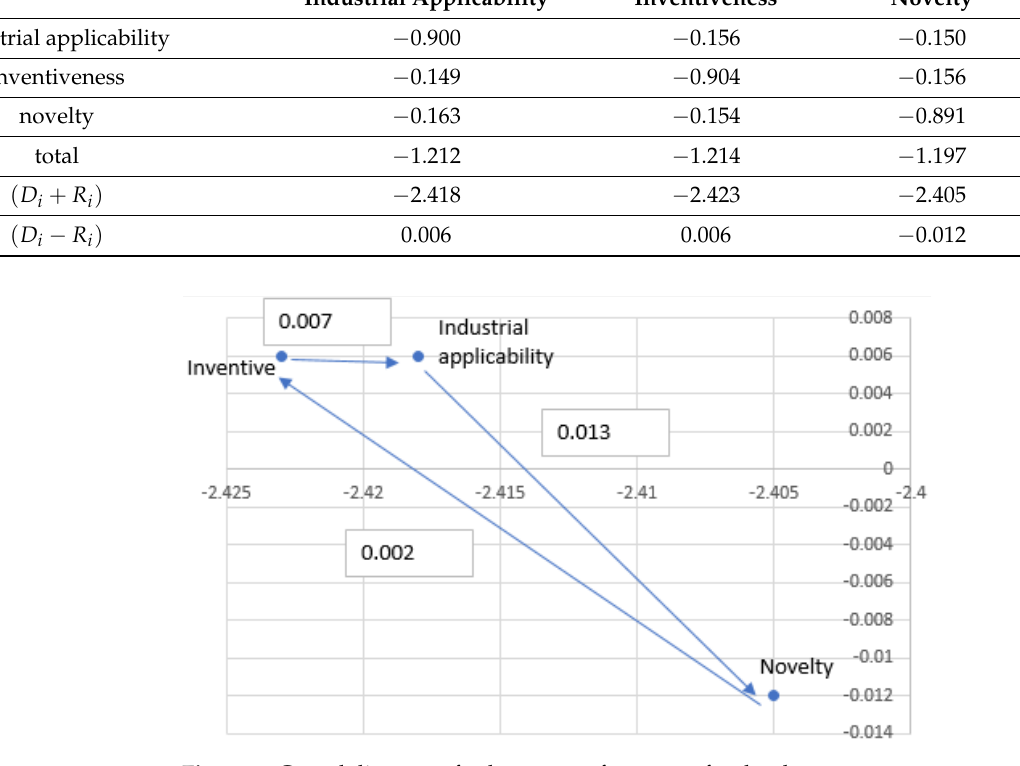
Figure 6. Causal diagram of sub-aspects of essence of technology.